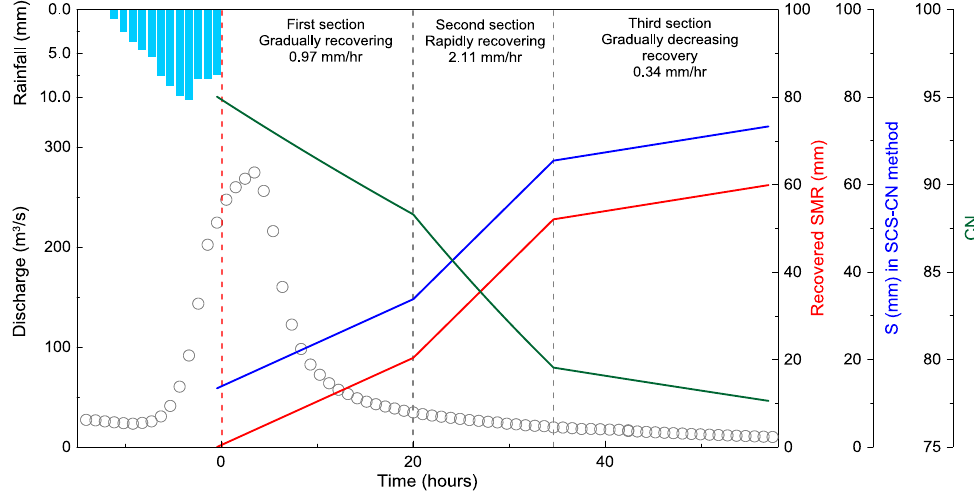
Figure 11. Final R-curve and its application with the recovery rate in Napa River basin: In this figure, circles indicate the hydrograph, the red line represents the R-curve with recovery rates, and the blue greed lines are the value S and CN of CN method at a time step. From this figure, it is possible to identify the amount of recovered SMR at a time step (hourly) and a variation of S and CN depending on the intervals of no rain (INRs).